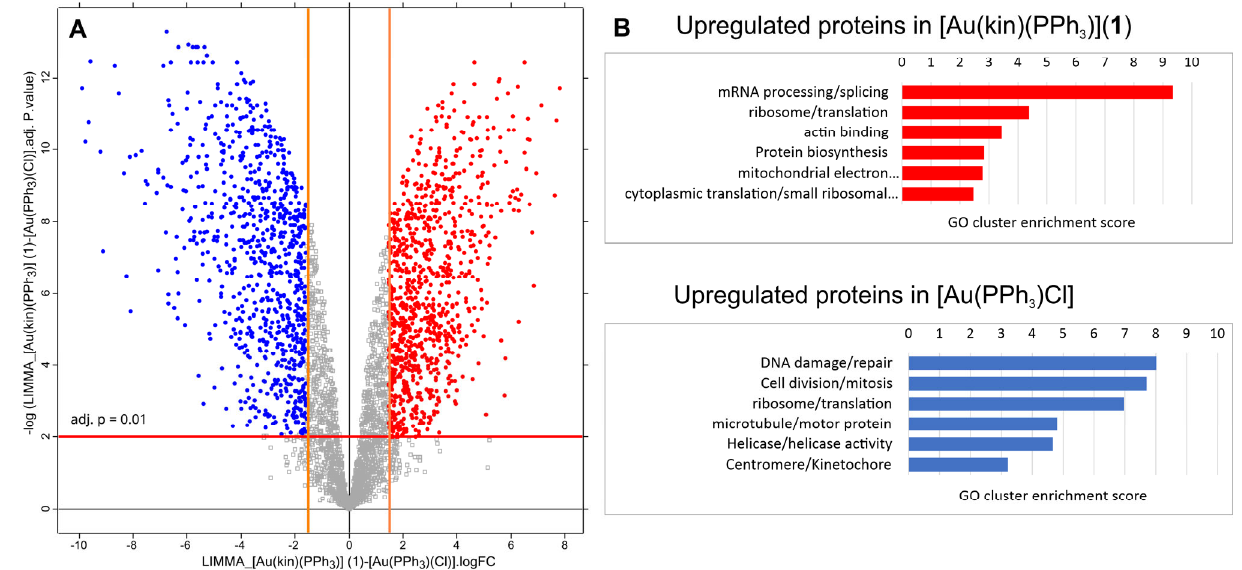
Figure 12. ( A ) The volcano plot of differences at protein levels between samples treated with [Au(kin)(PPh 3 )] ( 1 ) versus [Au(PPh 3 )Cl]. The lines in the chart define the stringency of detecting upregulated proteins. The red line represents the adj. p -value at 0.01. The orange lines define the minimal limits of protein fold-change to be taken as upregulated. They were set to log2(FC) equal to 1.58, which states that the change of the protein level between differentially treated samples must be at least three times higher. Red dots represent the proteins upregulated in the sample treated with the complex [Au(kin)(PPh 3 )] ( 1 ). Conversely, the blue dots represent the proteins upregulated in the sample treated with the complex [Au(PPh 3 )Cl]. ( B ) Summary of the enrichment of GO terms for upregulated proteins in each sample. The volcano plot was created by the Perseus tool v. 2.0.7.0.